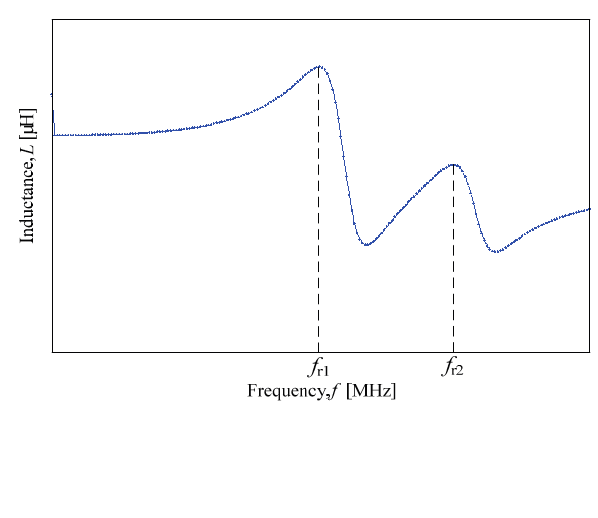
Figure 5. Expected dual resonant frequencies.